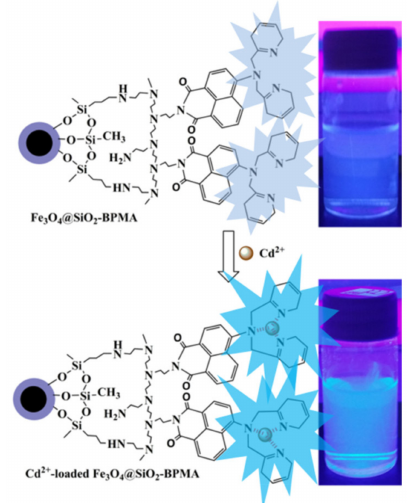
Figure 8. Binding mechanism of Fe 3 O 4 @SiO 2 -BPMA toward Cd 2 +